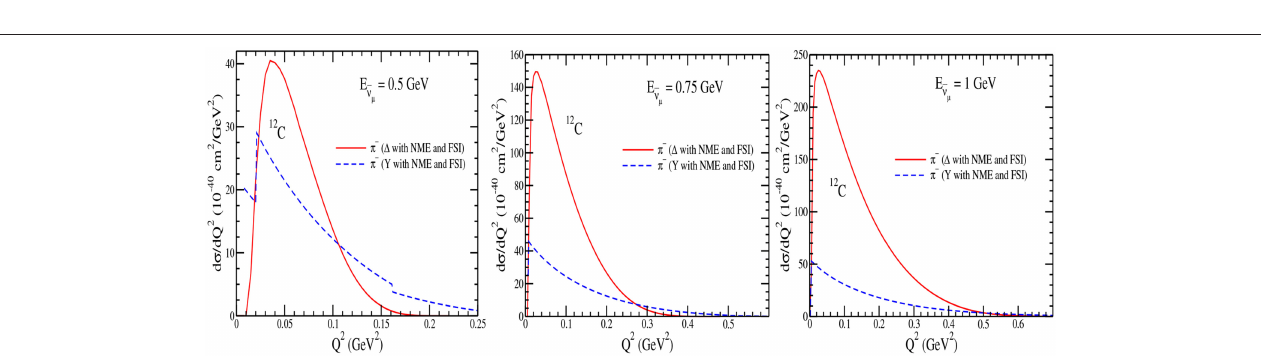
vs Q 2 at E FIGURE 21 | d σ ν µ = 0.5 GeV (left) , 0.75 GeV (middle) , and 1 GeV (right) for the ¯ ν µ induced process in 12 C nuclear target with NME+FSI. The results dQ 2 ¯ are shown for the π − contribution from the 1 (solid line) and from the hyperons (dashed line).